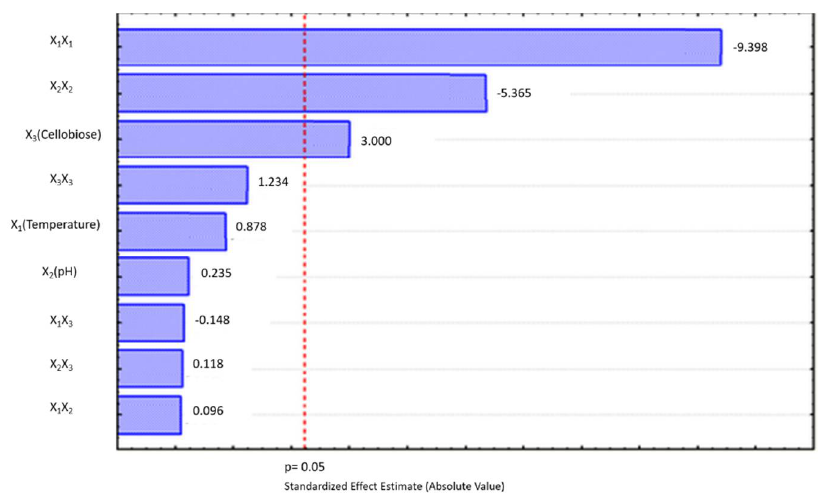
Figure 3. Standardized effect of temperature (X 1 ), initial pH value (X 2 ), and cellobiose concentration